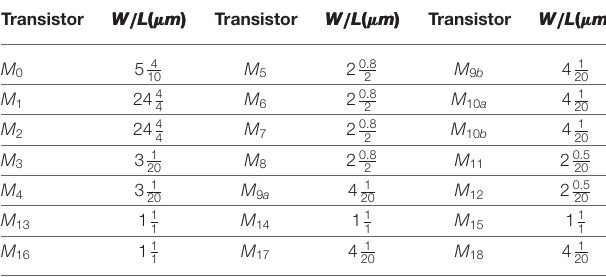
TABLE 1 | Transistor sizes of the neural amplifier.